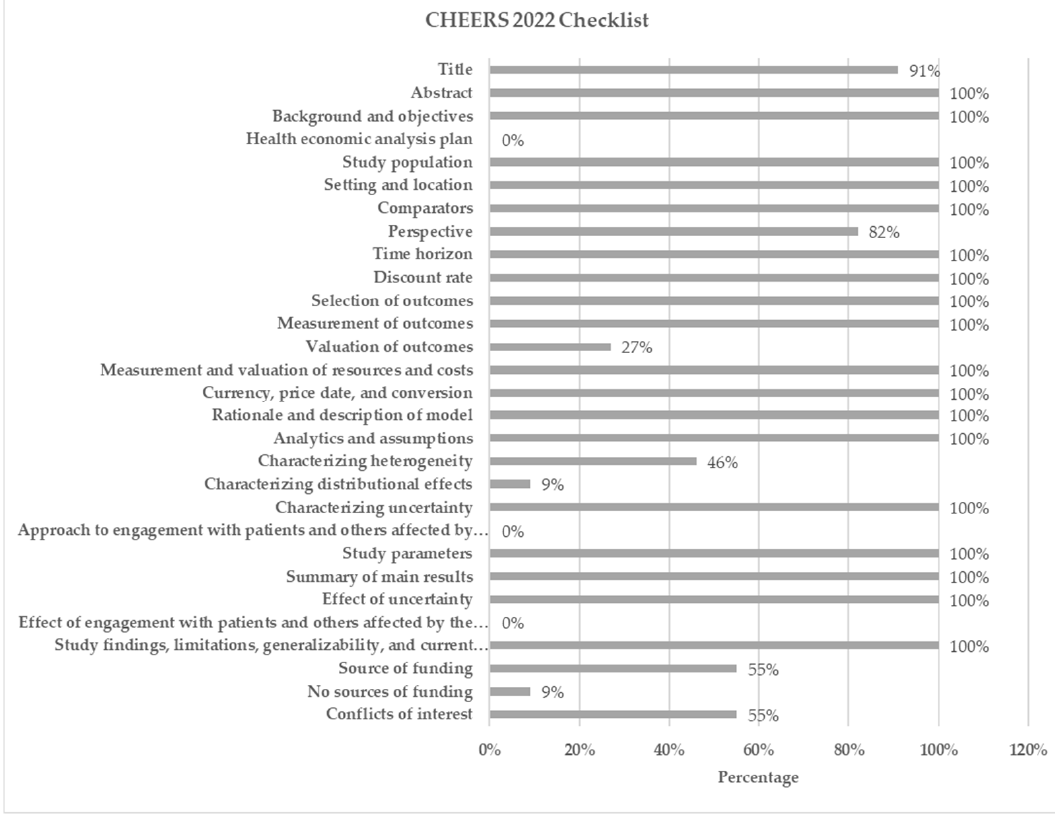
Figure 3. Quality of reporting results based on the 2022 CHEERS checklist